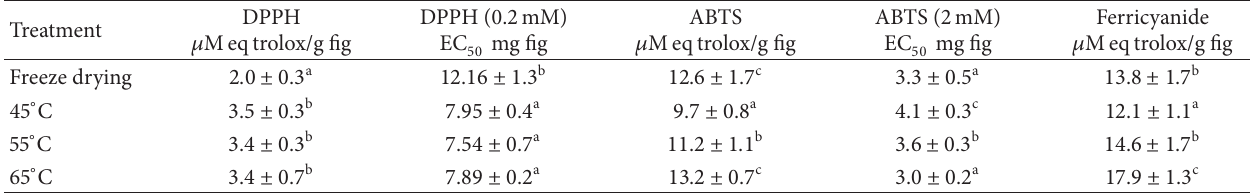
Table 6: Antioxidant activity of dried half cut